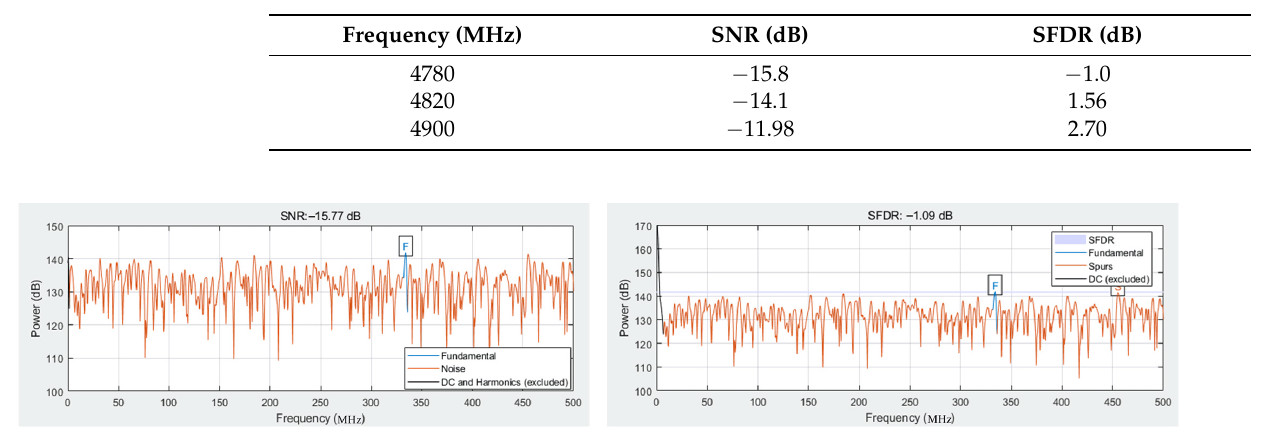
Table 3. Parameters of SNR and SFDR.